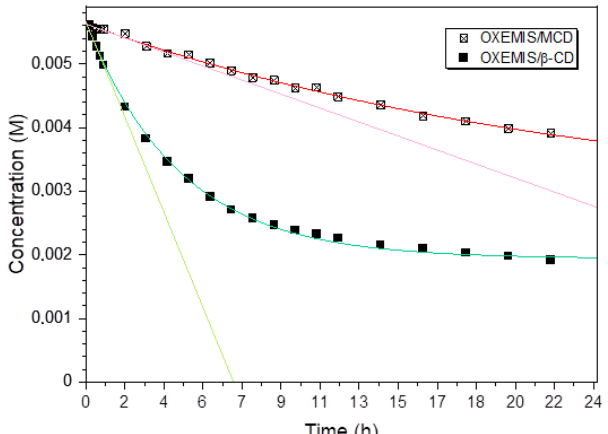
Figure 5. OXEMIS concentration in the presence of 2-equivalents of β -CD or MCD (12 mM) in D 2 O (K 2 HPO 4 50 mM) over time, as detected by 1 H NMR (600 MHz, 25 °C). Therefore, the hydrolysis of OXEMIS is correlated with the availability of free reactive -OH groups in the cyclodextrin, able to establish hydrogen bonds, probably with the hemisuccinic pendant. Accordingly, DIMEB and TRIMEB did not produce hydrolysis within the 24 h, pointing out the relevance of the interaction of hemisuccinic chain with the hydroxyls at the C 2 and C 6 sites.